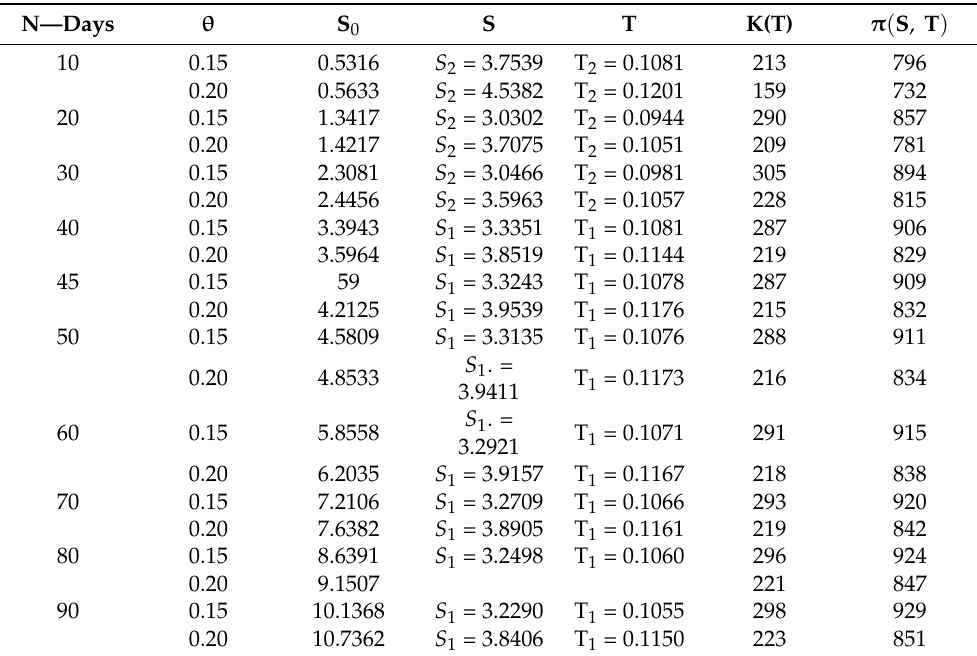
Variations in net profit when